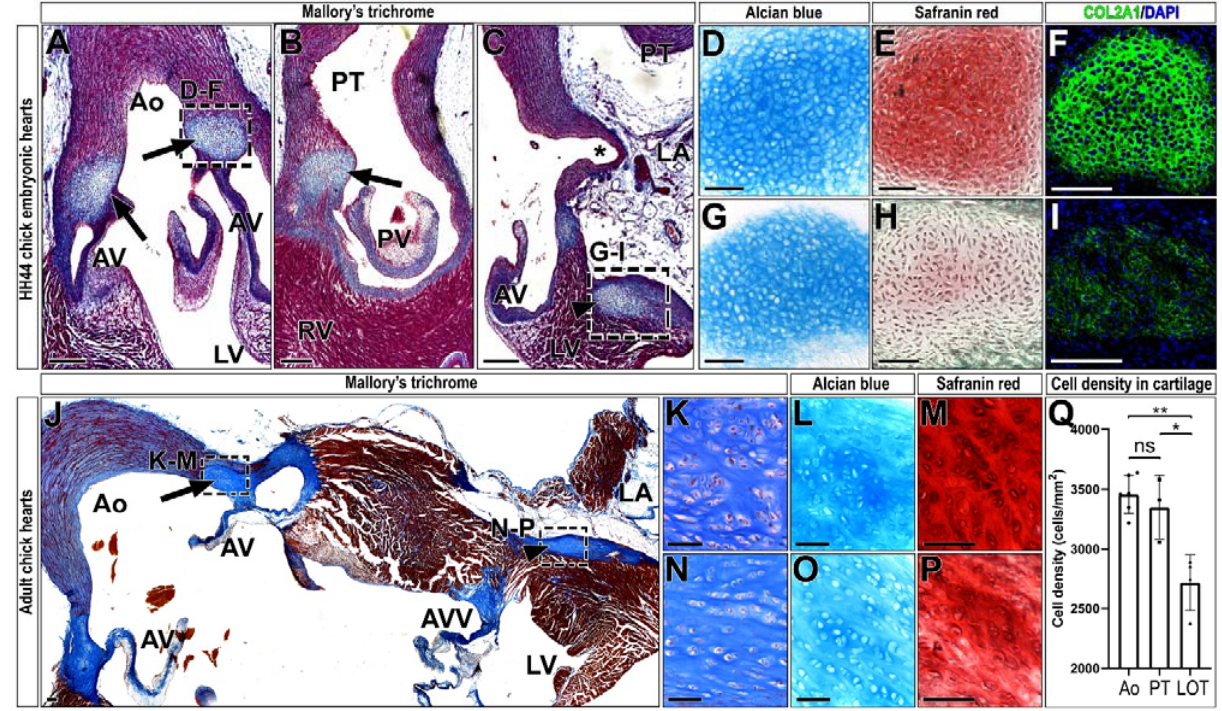
Figure 1. Chick cardiac chondrocyte clusters are ontogenetically heterogeneous. ( A – I ) Identification of chondrocyte clusters in HH44 chick embryonic hearts. Mallory’s trichrome staining shows an accumulation of fibrous tissue (blue) in the aortic ( A ) and pulmonary valves ( B ), and in the